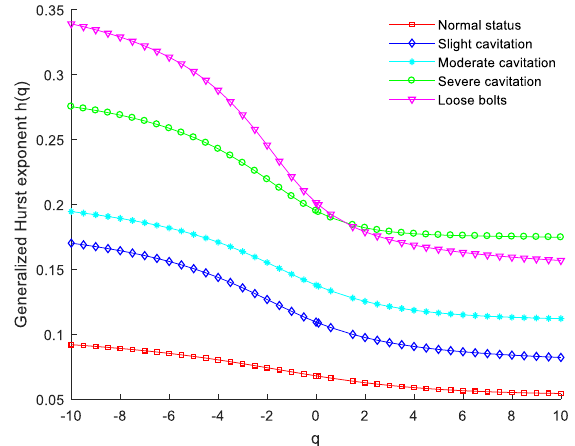
Figure 5. Generalized Hurst exponent of centrifugal pump vibration signals.